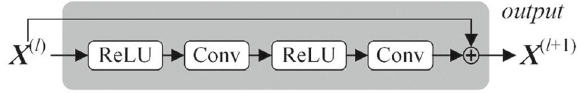
Fig. 4 Residual deep convolutional neural